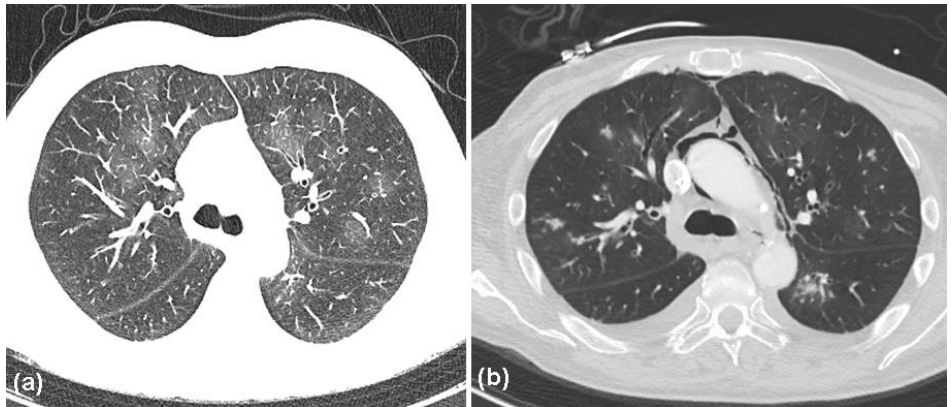
Figure 7. Computed tomography (CT) scans of the chest. ( a ) Subtle mosaic attenuation, ground-glass opacities, bronchiectases, and bronchial wall thickening, consistent with a diagnosis of bronchiolitis obliterans (BO); ( b ) pneumomediastinum as a further complication of BO.